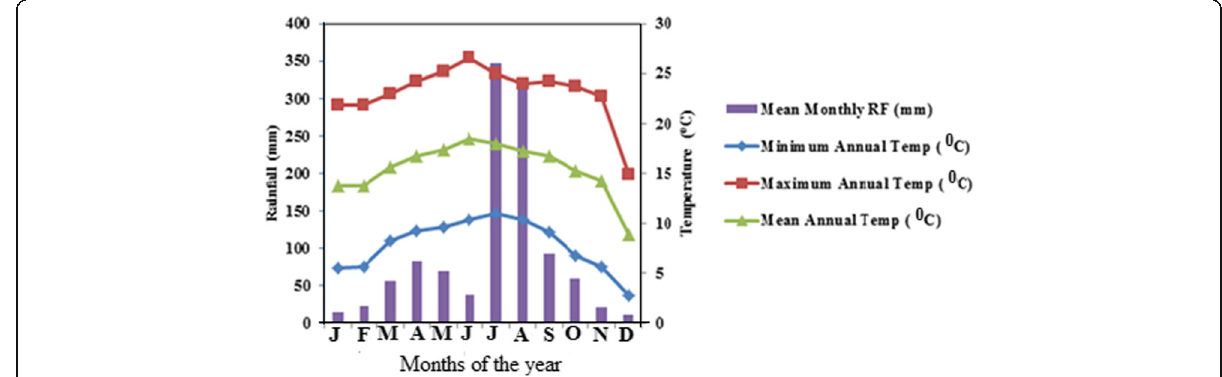
Fig. 2 Min., max., and mean annual temperature and mean monthly rainfall of the study